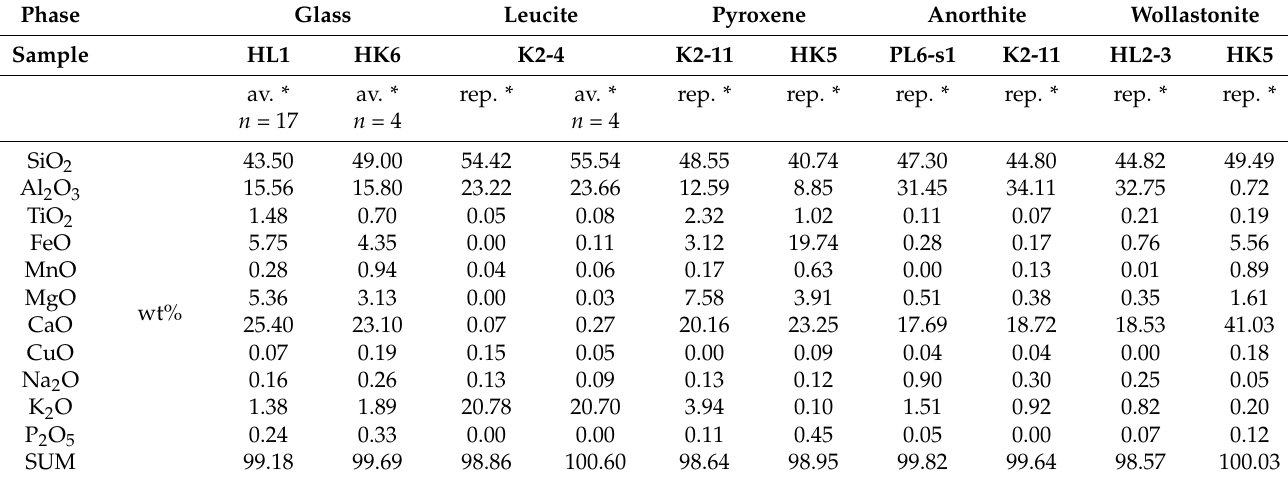
Table 4. EMPA results of phases analyses (Phase Assemblage